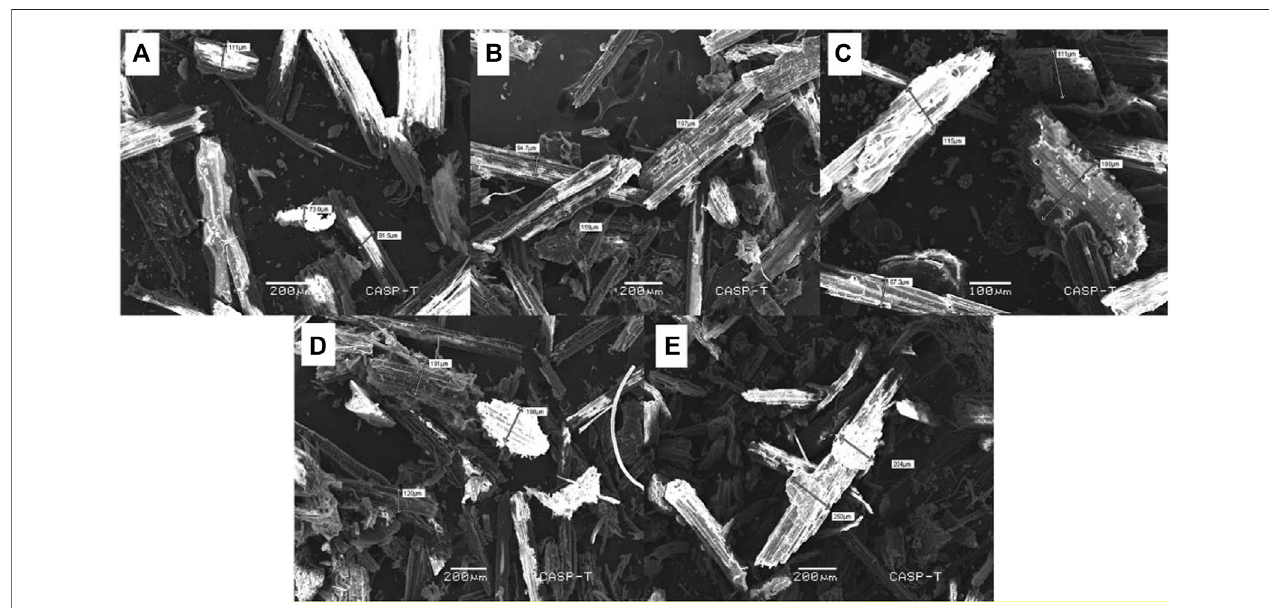
FIGURE1|(A) SEMimagesofwheathusk, (B) compositeofthewheathuskandpolyaniline, (C) compositeafterCuadsorption, (D) compositeafterPbadsorption, and (E) composite after Ni adsorption showing the size enhancement after heavy metal adsorption.